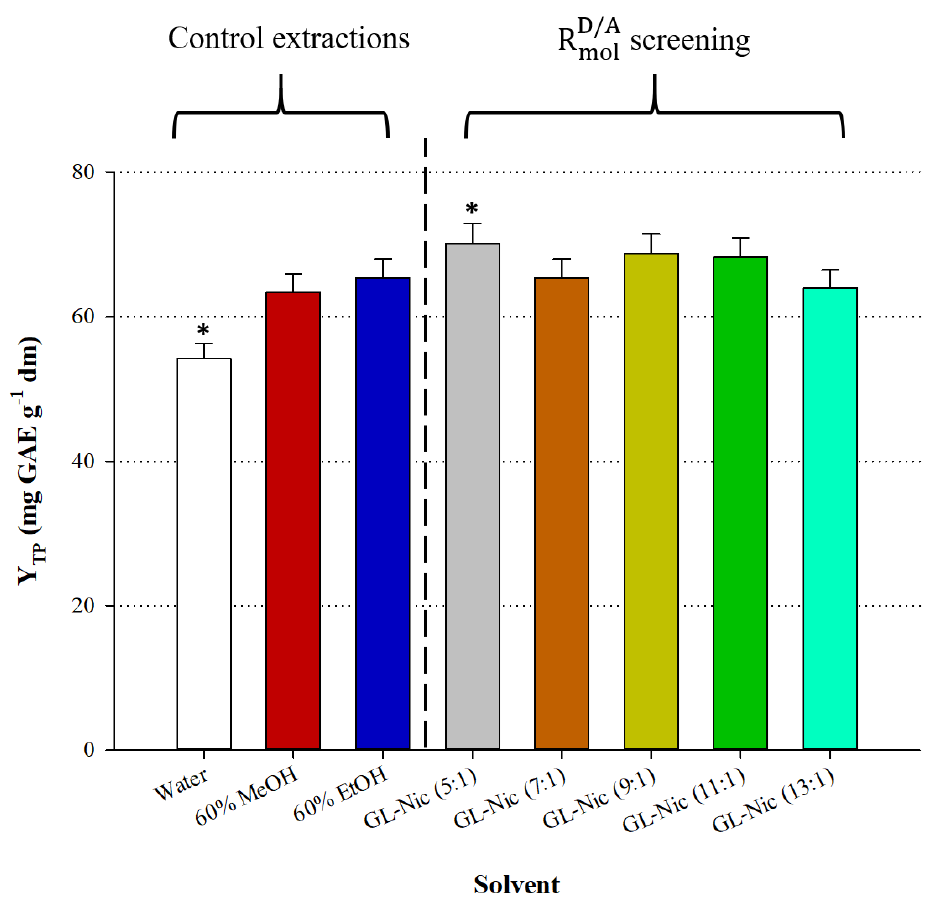
Figure 1. Plot showing the effect of R molD/A on the extraction effectiveness of the DES tested. Extractions were carried out at 50 °C, with C DES = 70% ( w/v ), at 500 rpm, for 150 min. Assignment with “*” denotes statistically different value.